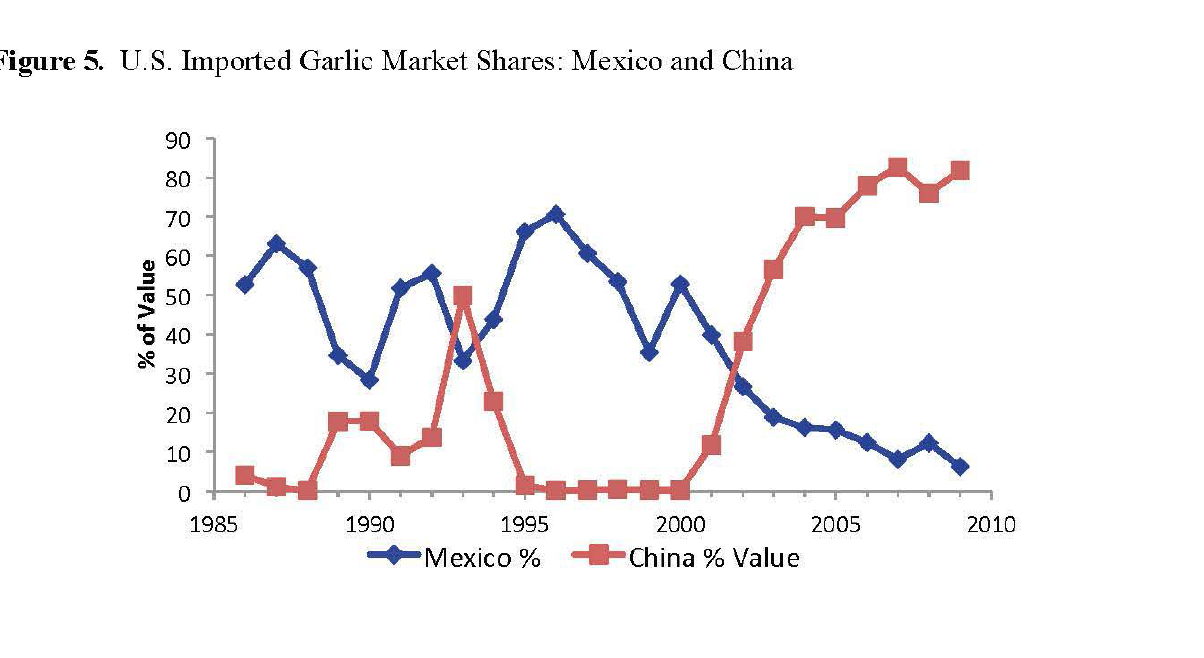
Figure 5. U.S. Imported Garlic Market Shares: Mexico and